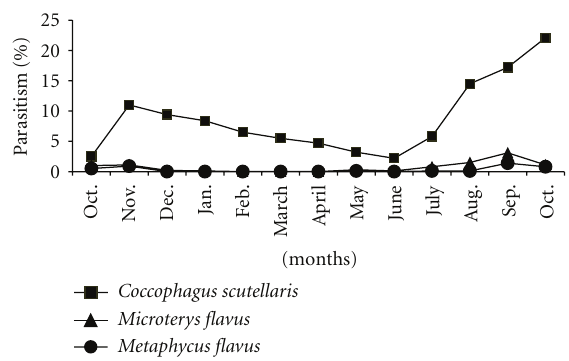
Figure 1: Percent parasitism of Coccophagus scutellaris and other associated parasitoidsof Ceroplastes floridensis on citrus in Gharbiya governorate after releasing during 2009-2010.